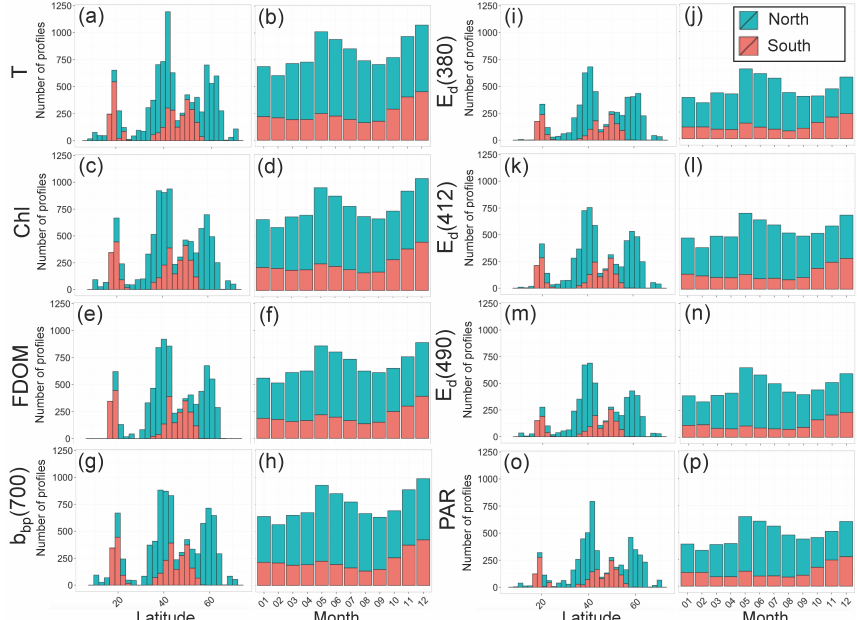
Figure 7. Latitudinal and monthly distributions of the 9837 vertical profiles, presented as stacked histograms, for (a–b) temperature ( T ), (c– d) chlorophyll a concentration (Chl), (e–f) fluorescent dissolved organic matter (FDOM), (g–h) particulate optical backscattering coefficient at 700nm ( b bp (700)), (i–j) downward irradiance at 380nm ( E d (380)), (k–l) downward irradiance at 412nm ( E d (412)), (m–n) downward irradiance at 490nm ( E d (490)), and (o–p) photosynthetically available radiation (PAR). Vertical profile distributions are displayed for both Northern and Southern